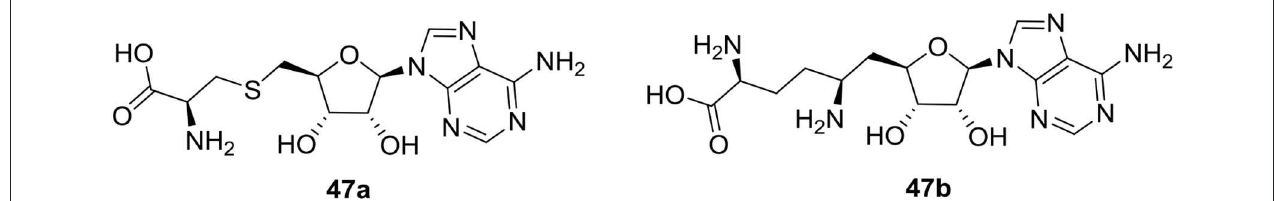
FIGURE 13 | Structures of S-adenosyl-homocysteine ( 47a ) and sinefungin ( 47b